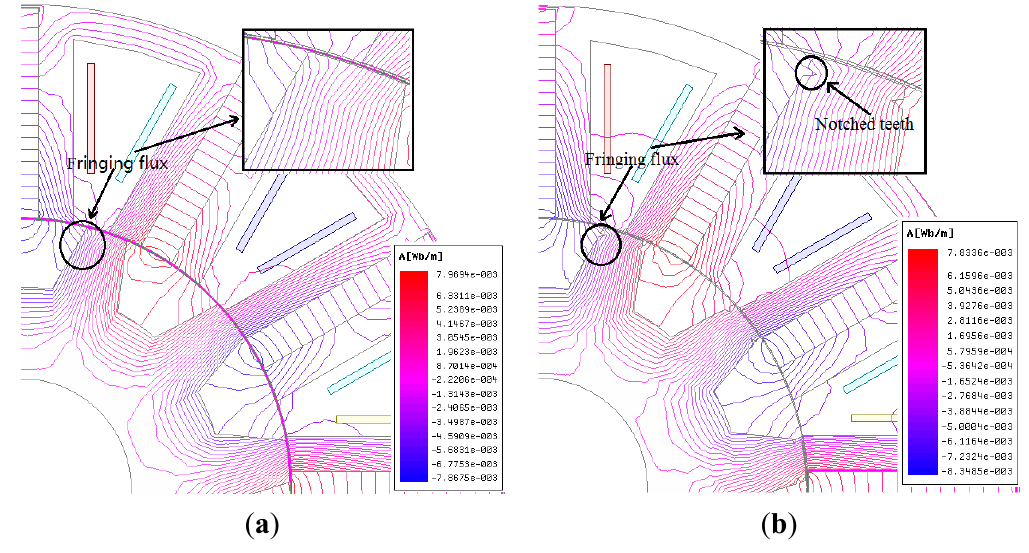
Figure 4. The flux distribution: ( a ) initial model; and ( b ) rotor with notched teeth